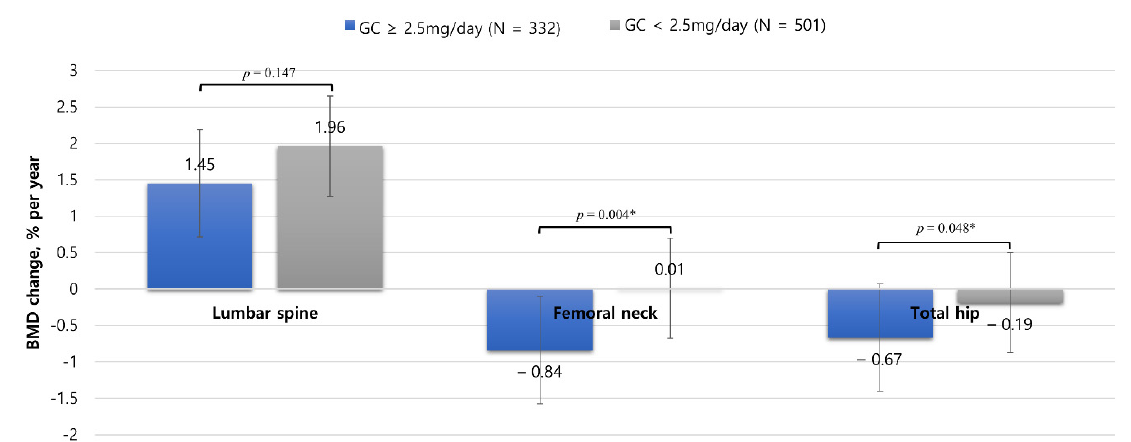
Figure 3. Annual rates of change in the bone mineral density of the lumbar spine, femoral neck, and total hip according to the mean daily glucocorticoid dose. Error bars represent the standard error of the mean. GC: Glucocorticoid, BMD: bone mineral density. * p < 0.05.